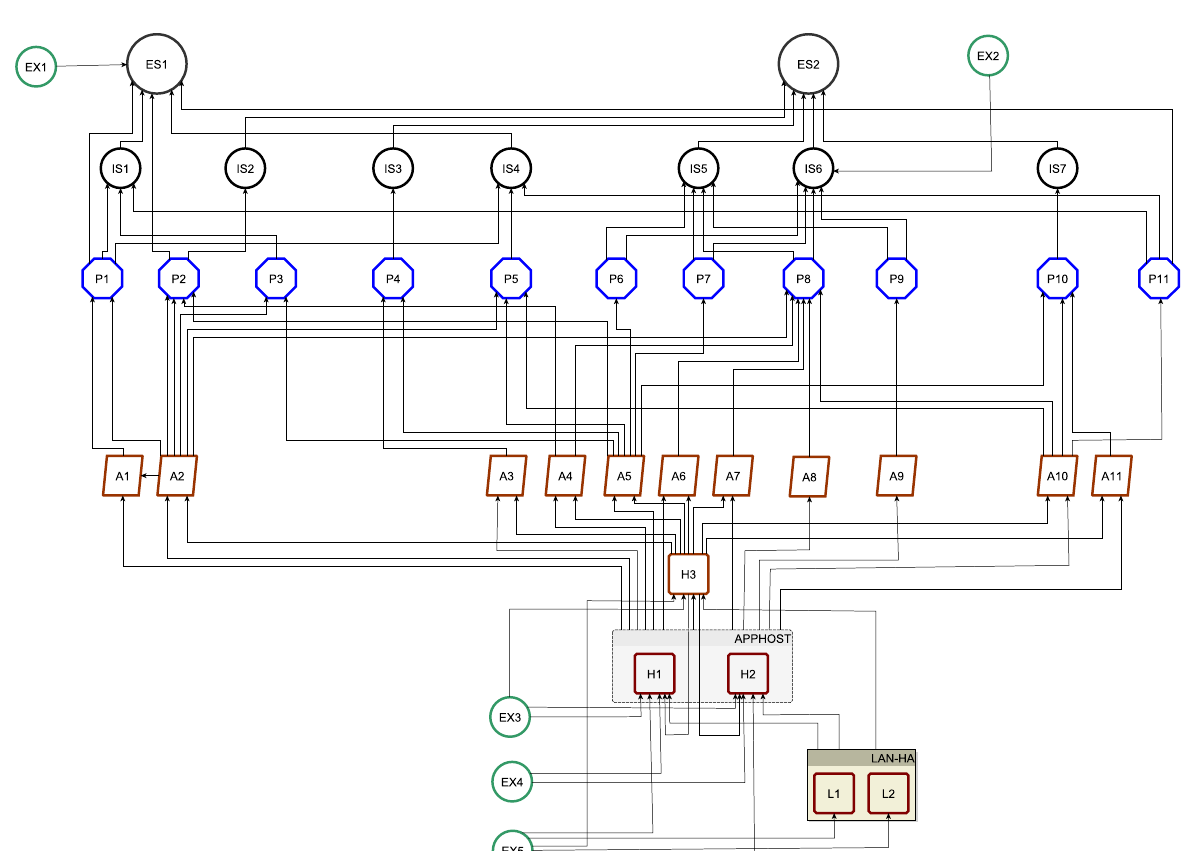
Figure 7. Selected part of the operator